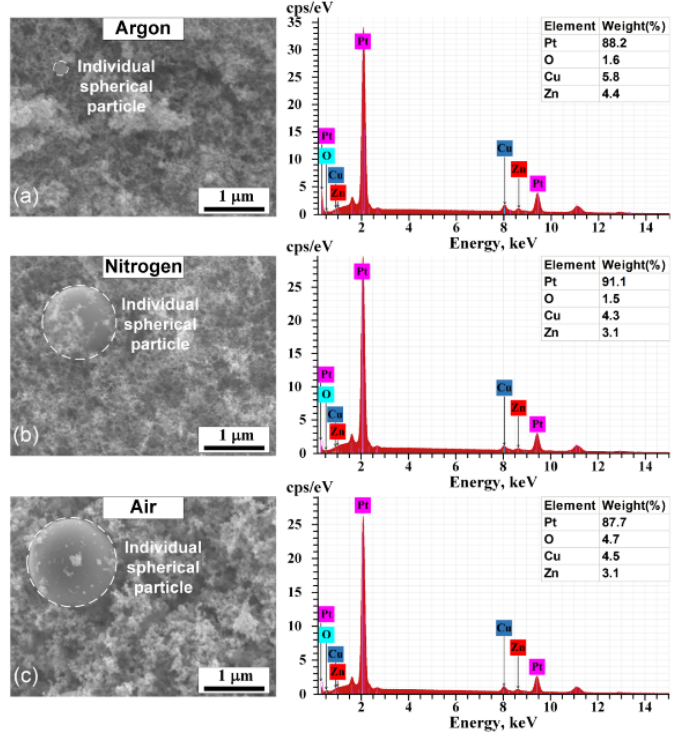
Figure 2. TEM images of aggregates, primary and individual spherical platinum nanoparticles (PtNPs) synthesized by SDG in various gases: ( a , b ) Ar, ( c , d ) N 2 , and ( e , f ) air. The insets show the corresponding electron diffraction patterns.